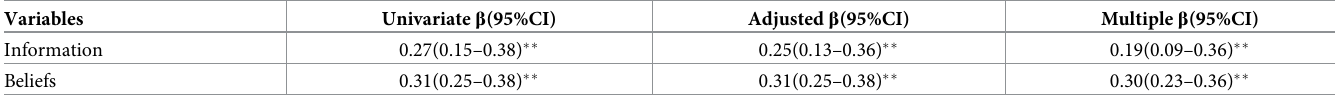
Table 2. Information, beliefs associated with self-efficacy among participants (N =